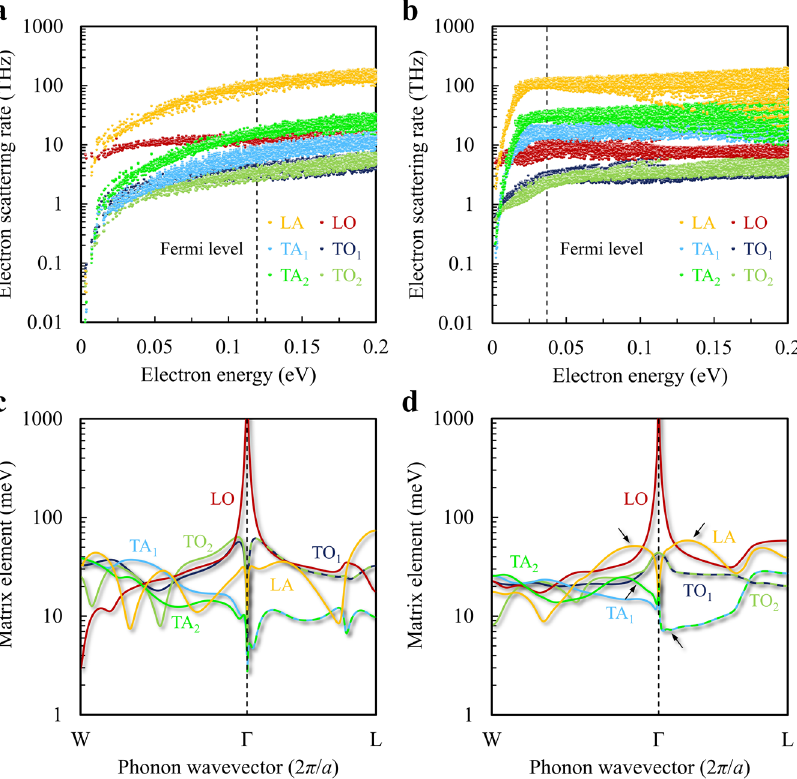
Fig. 4 Ab initio electron scattering rates due to each phonon mode at 300 K with a doping concentration of 10 20 cm – 3 . a The unstrained and b 3% compressed SnTe. The dashed black lines show the Fermi levels. Magnitudes of the coupling matrix elements between an electron at the CBM and the phonons in the Γ W and Γ L directions of the c unstrained and d 3% compressed SnTe. The black arrows indicate the enhancement in the matrix elements arising from a 3% compressive